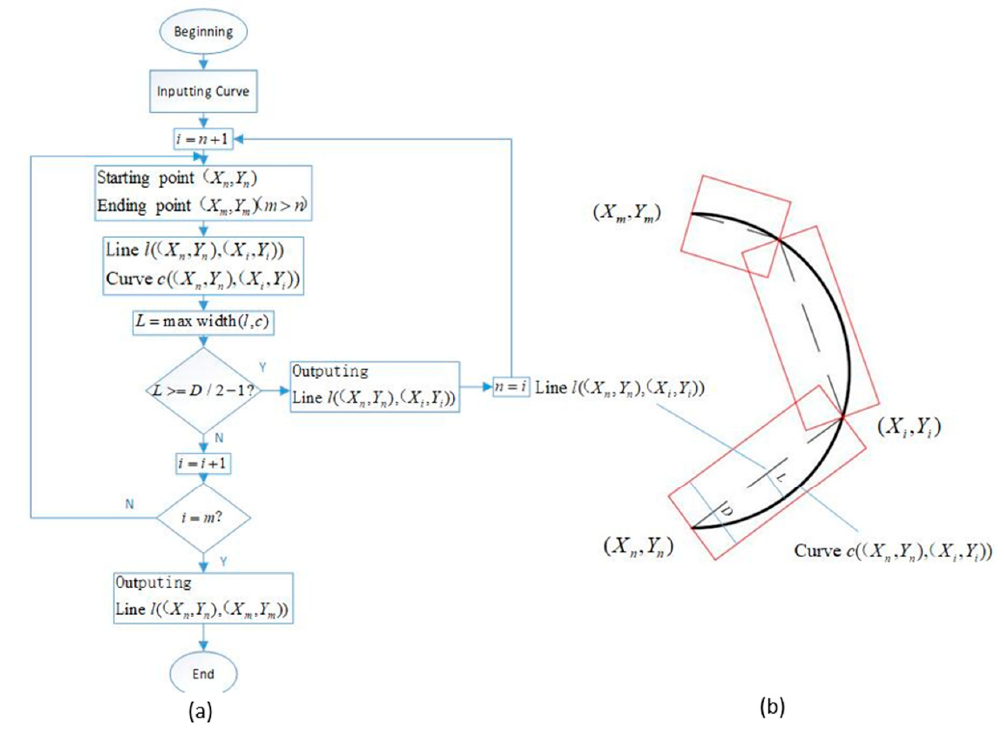
Figure 4. (a) The flow chart for converting curve to line and (b) the result of converting curve to line.